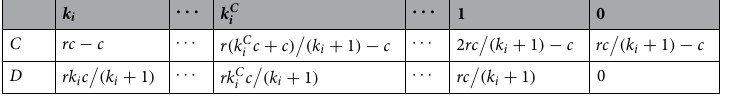
Table 2. Payoff matrix of multiplayer public goods evolutionary